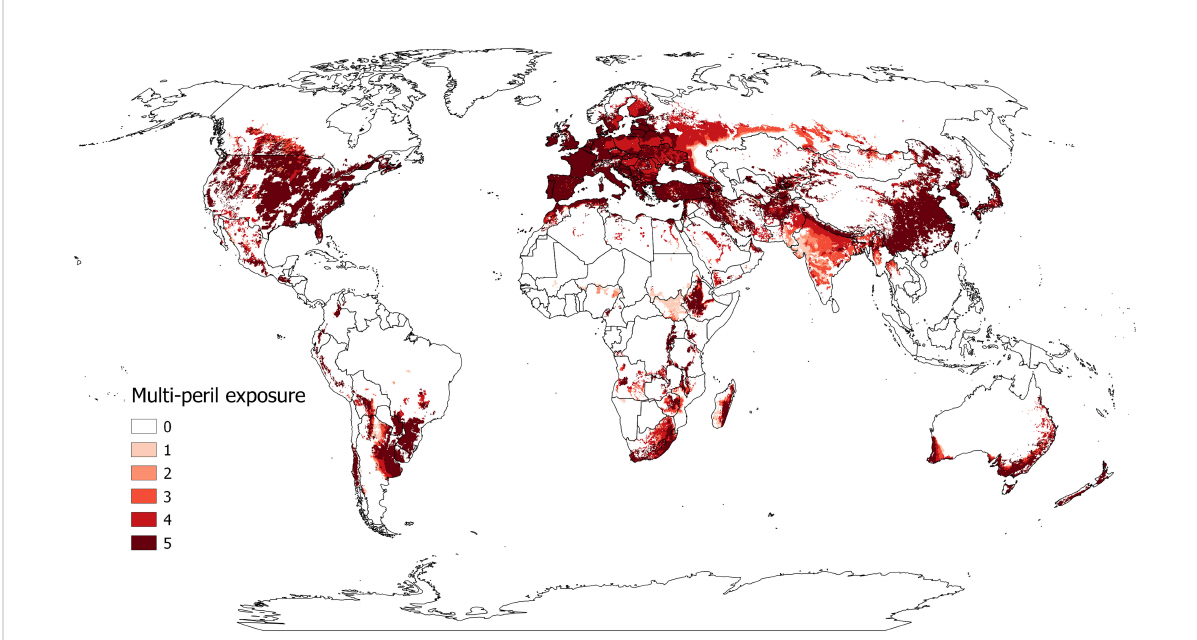
FIGURE 1 Modeled global climate-based multi-peril exposure for selected wheat fungal diseases. This map reports the climate-based multi-peril exposure (pest suitability count) of modeled CLIMEX annual growth indexes (GI) for the following wheat fungal diseases: stem rust, stripe rust, leaf rust, FHB, and septoria tritici blotch. The map shows the count of disease suitability (i.e., GI > 5) within the global wheat production areas reported by the Spatial Allocation Model (SPAM) (Yu et al.,